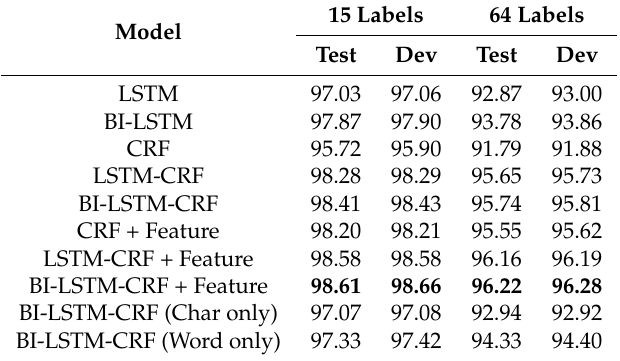
Table 7. Statistics of the partition on each corpus.